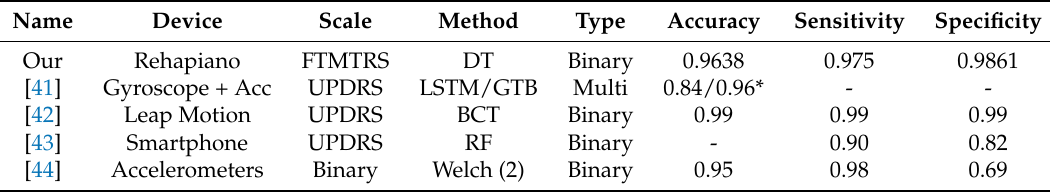
Table 4. Comparison of different classifiers approaches on PT (LSTM: long short-term memory; GTB: gradient tree boosting; BCT: bagged classification tree; RF: random